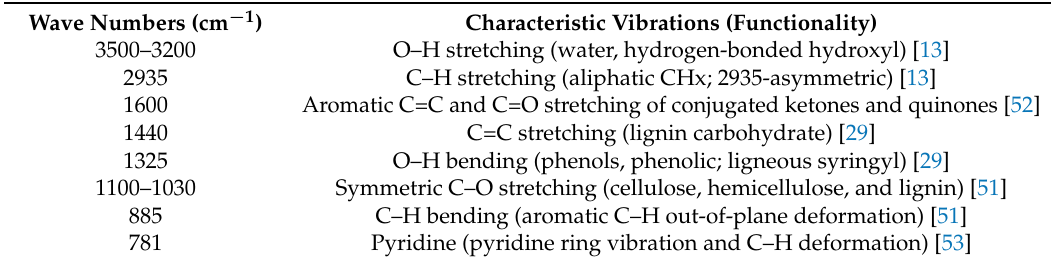
Table 3. Functional groups observed in the Fourier-transform infrared (FTIR) spectra of biocahrs produced at different